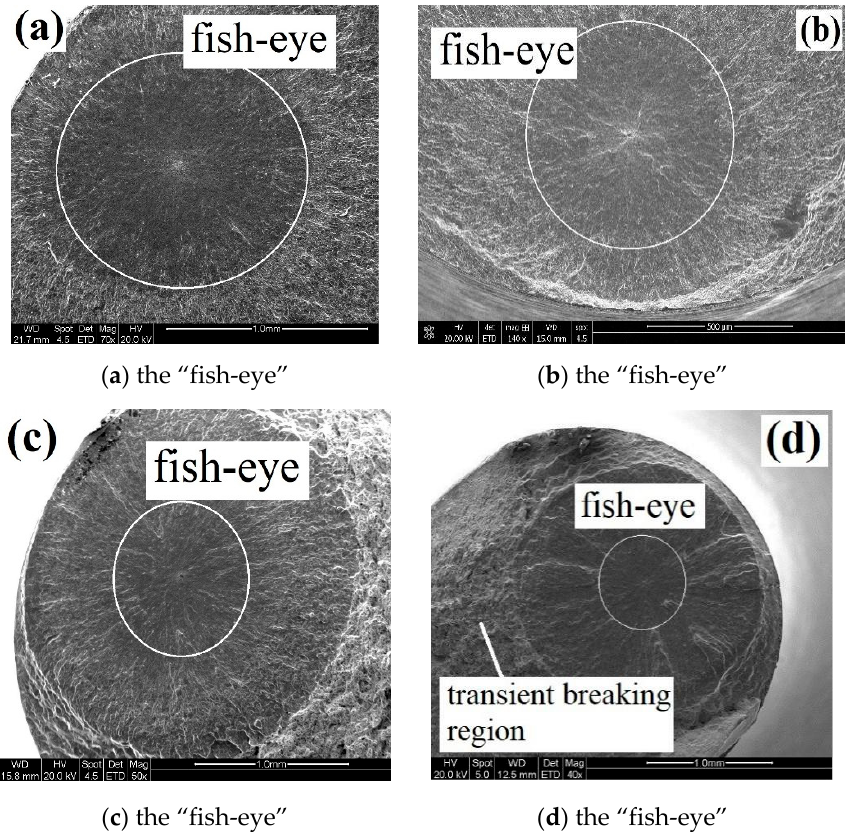
Figure 5. The “fish-eye” region.